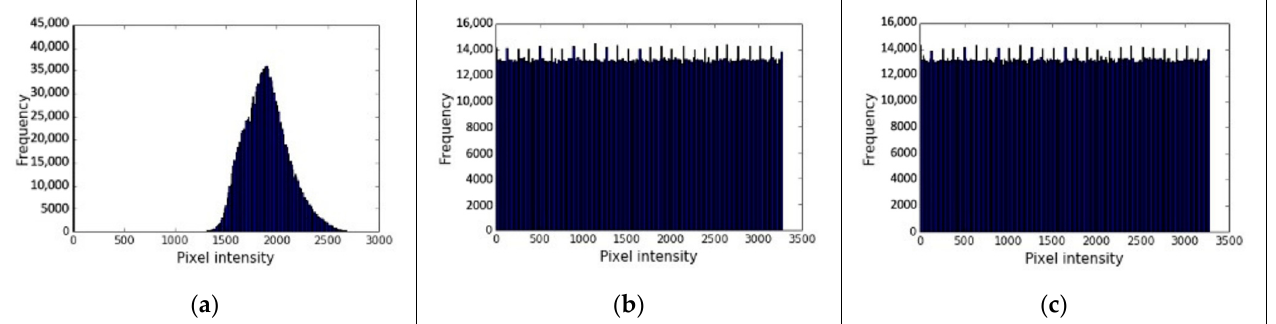
Figure 13. ( a ) Original image histogram, ( b ) Encrypted image (Frame-Based SE) histogram, and ( c ) Encrypted image (Holistic-Based SE) histogram.